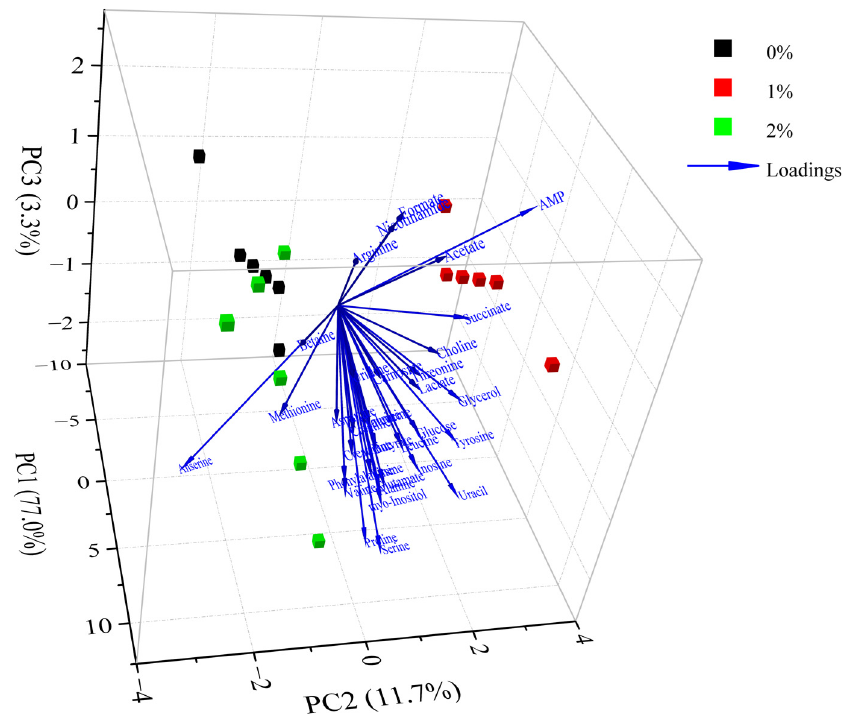
Figure 4. Principal component analysis of metabolites in Rugao hams treated with di ff erent levels of potassium lactate (0%, 1% and 2%). In order to further evaluate the di ff erences in the metabolite contents among di ff erent groups, PLS-DA analysis was performed; X-matrix was designed as the pro fi le of